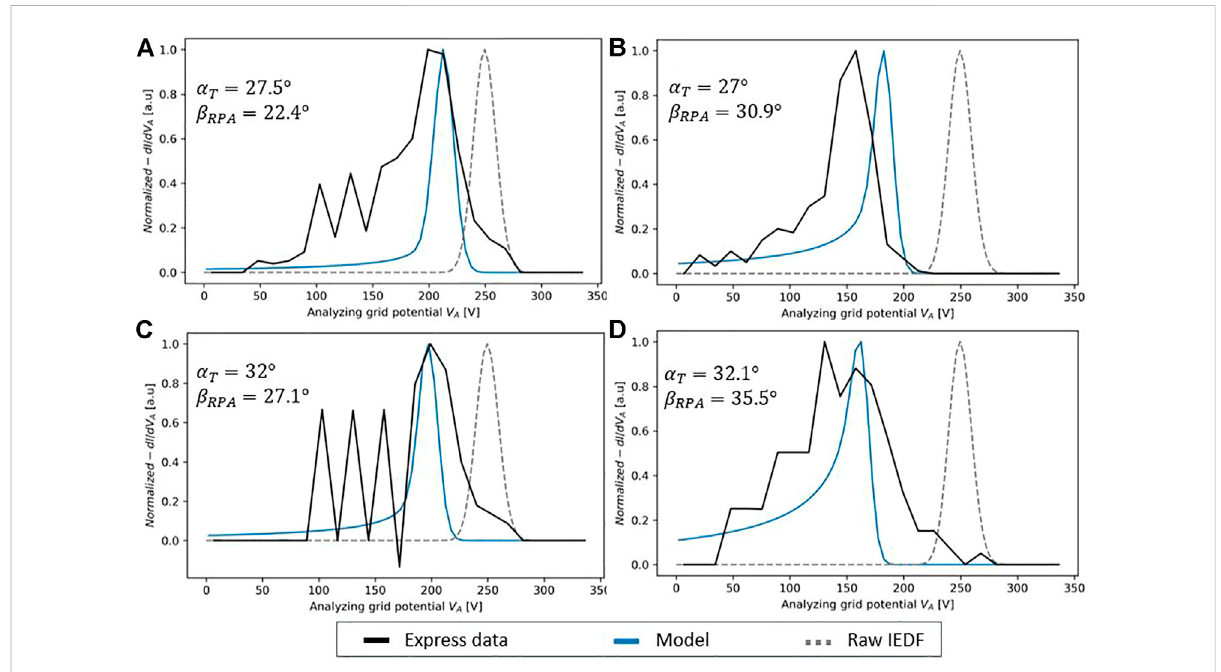
FIGURE 10 Normalized − dI / dV curves as a function of the analyzer potential. The processed Express-A data are compared to the model prediction and to the raw IEDF at the RPA location applied by the simulation. Shown for four con fi